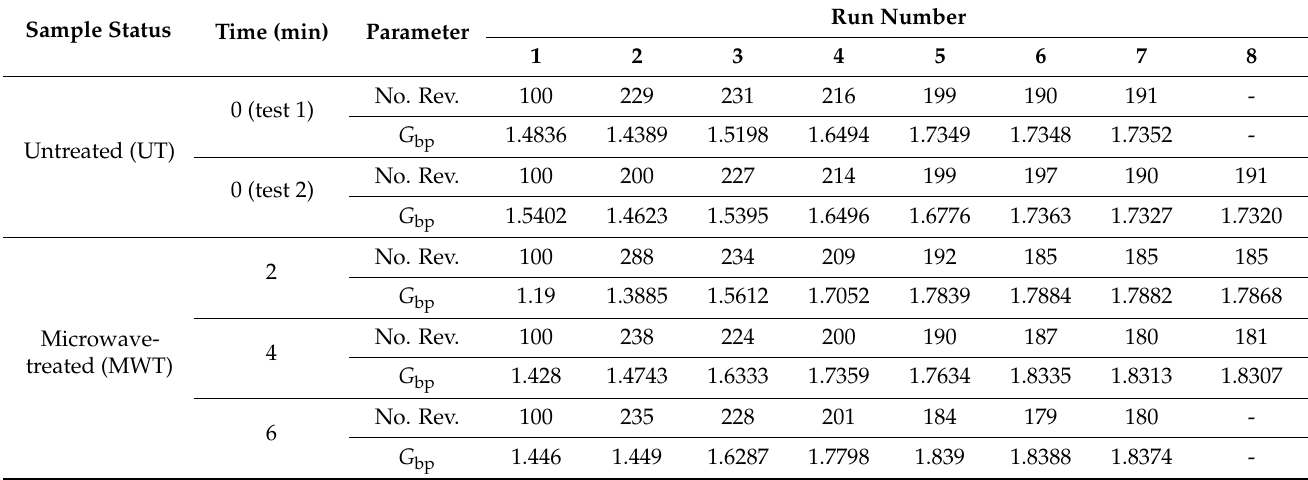
Table 2. Bond Ball mill grindability test results for different runs of sample S1 (sieve test size = 106 µ m; average pack density = 1.8321 g/cm 3 ).